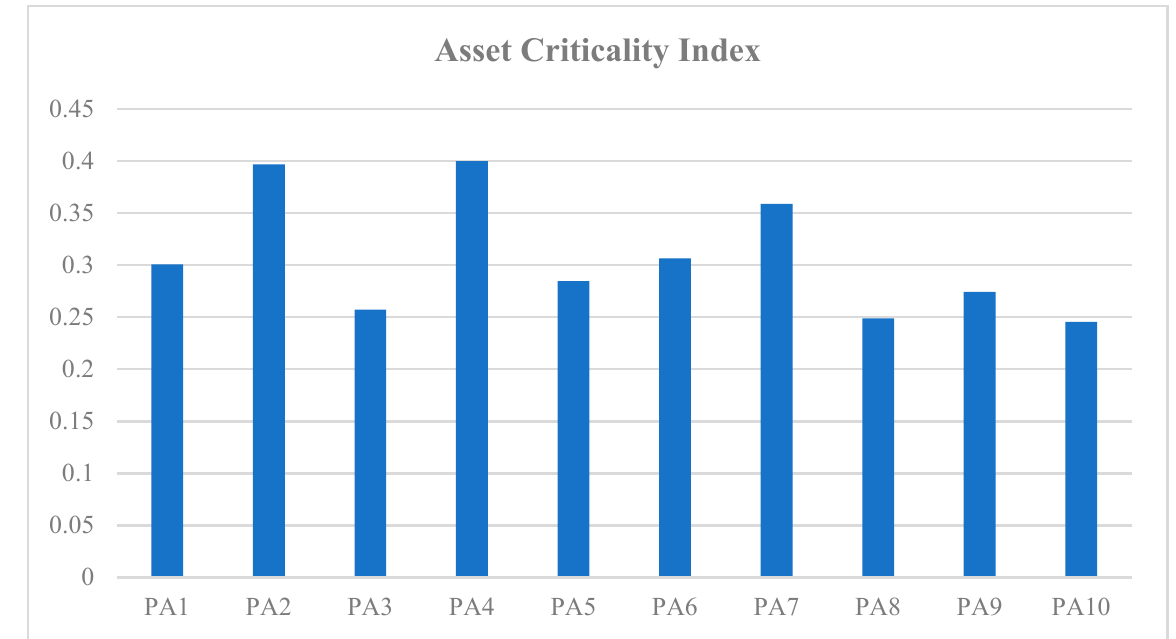
Figure 6. Asset criticality index for key physical assets in GP. PA stands for physical assets.